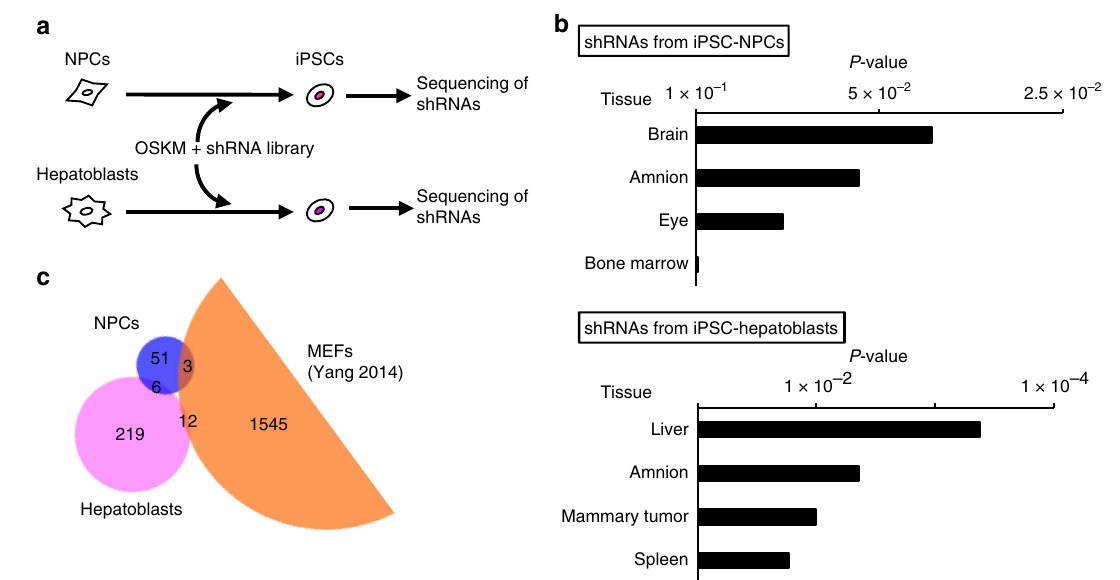
Fig. 1 Cell-type-speci fi c genes inhibit reprogramming. a Outline of the screening strategy used to identify factors that inhibit reprogramming. b Cell-type- speci fi c genes are enriched by the screenings. Genes enriched in the second screening of NPCs and the high positive fraction in the screening of hepatoblasts were subjected to tissue expression analysis with DAVID 18, 19 . Fisher ’ s exact test. c Factors that inhibit reprogramming are different among cell types. Identi fi ed genes from the second screening of NPCs, the high positive fraction in the screening of hepatoblasts and Yang et al. 20 were used to generate the Venn diagram. Numbers indicate the number of